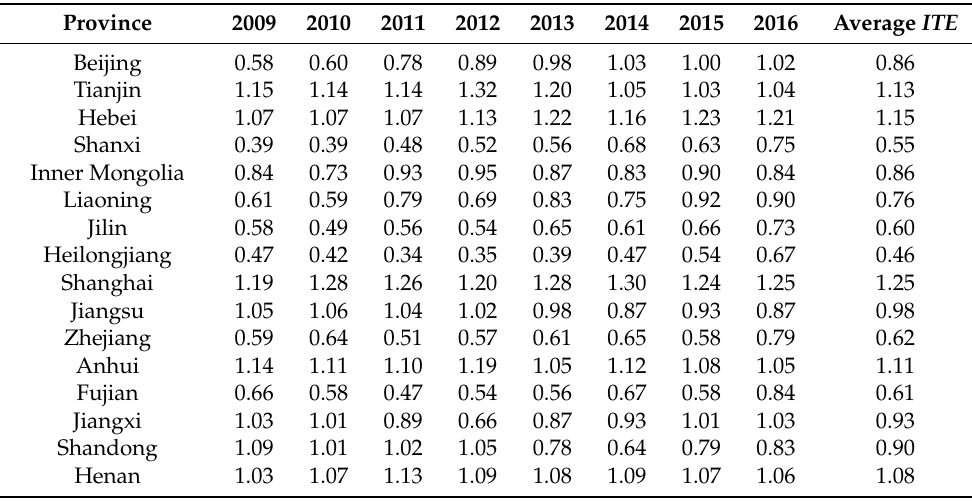
Table 3. ITE results from 2009 to